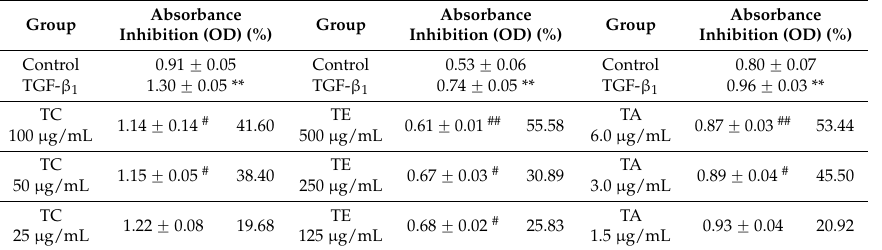
Inhibition effects of CPhGs, echinacoside and acteoside with different doses on TGF- β 1 -induced HSC proliferation.